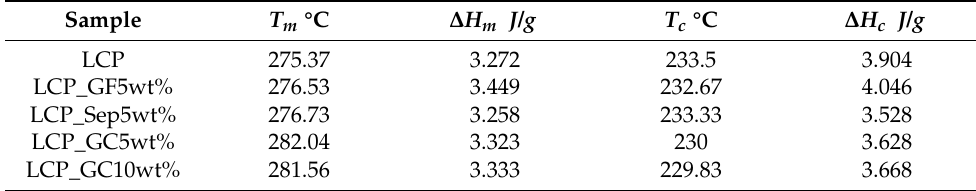
Table 1. Thermal analysis data of the LCP